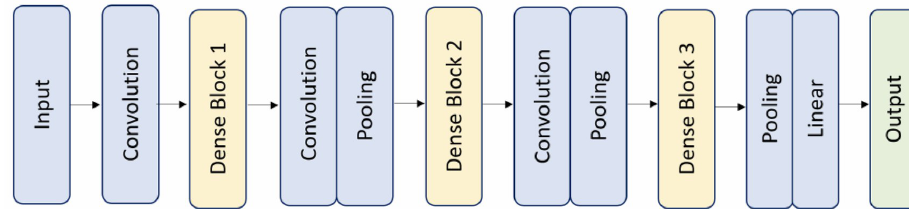
Figure 5. DenseNet model